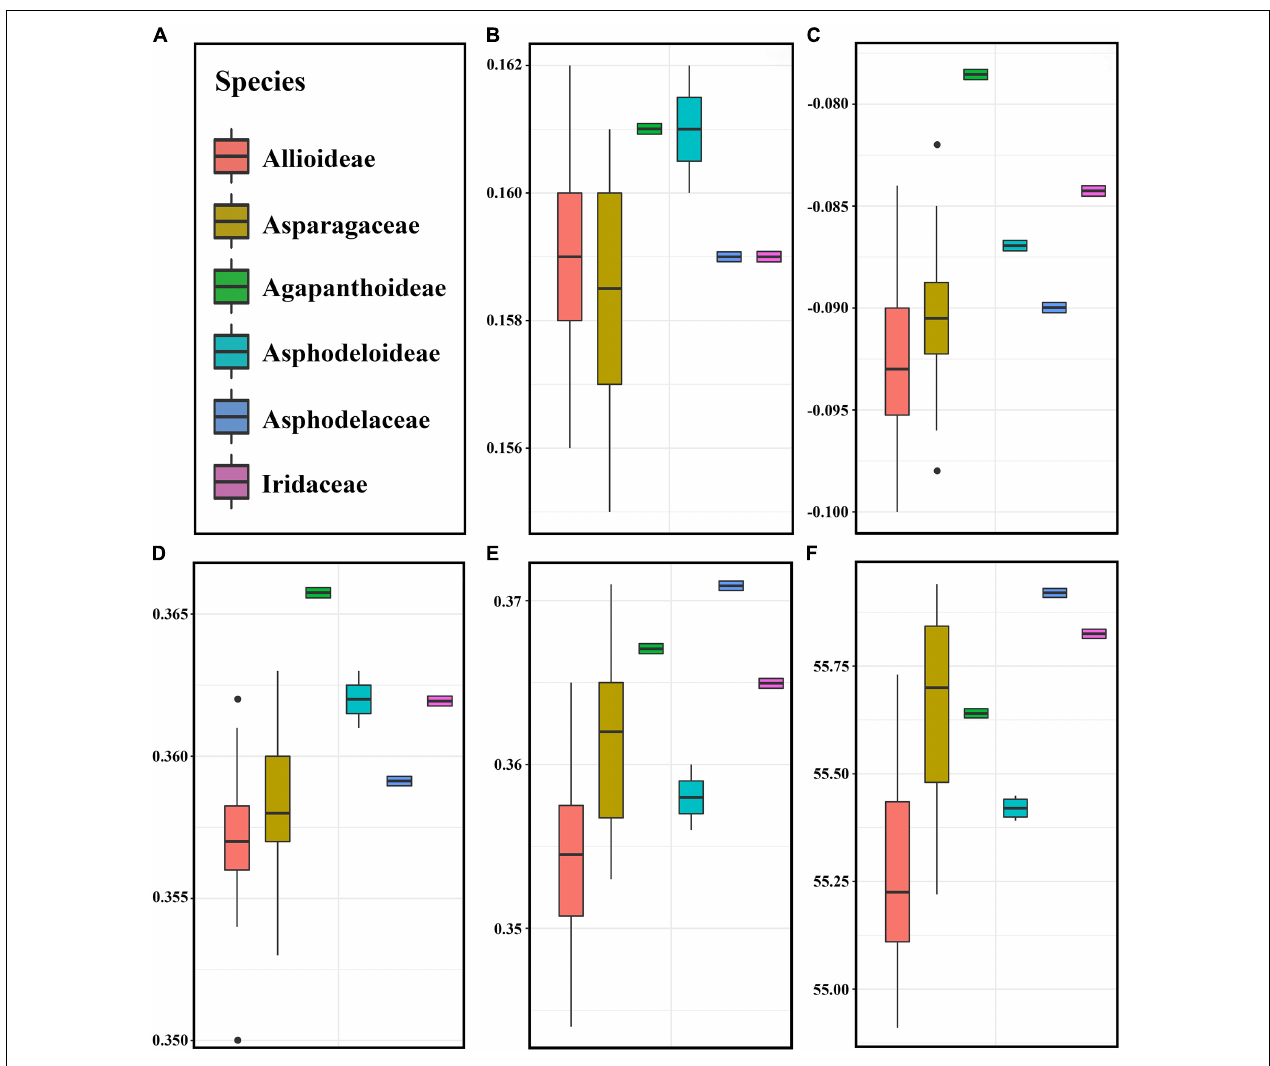
FIGURE 5 | The comparative analysis of codon usage bias in Allium (Allioideae) and other family species. (A) Labels representing each of families. (B) CAI (Codon adaptation index), (C) CBI (Codon bias index), (D) FOP (Frequency of optimal codons index), (E) GC3s (GC of synonymous codons in 3rd position), (F) ENC (Effective number of